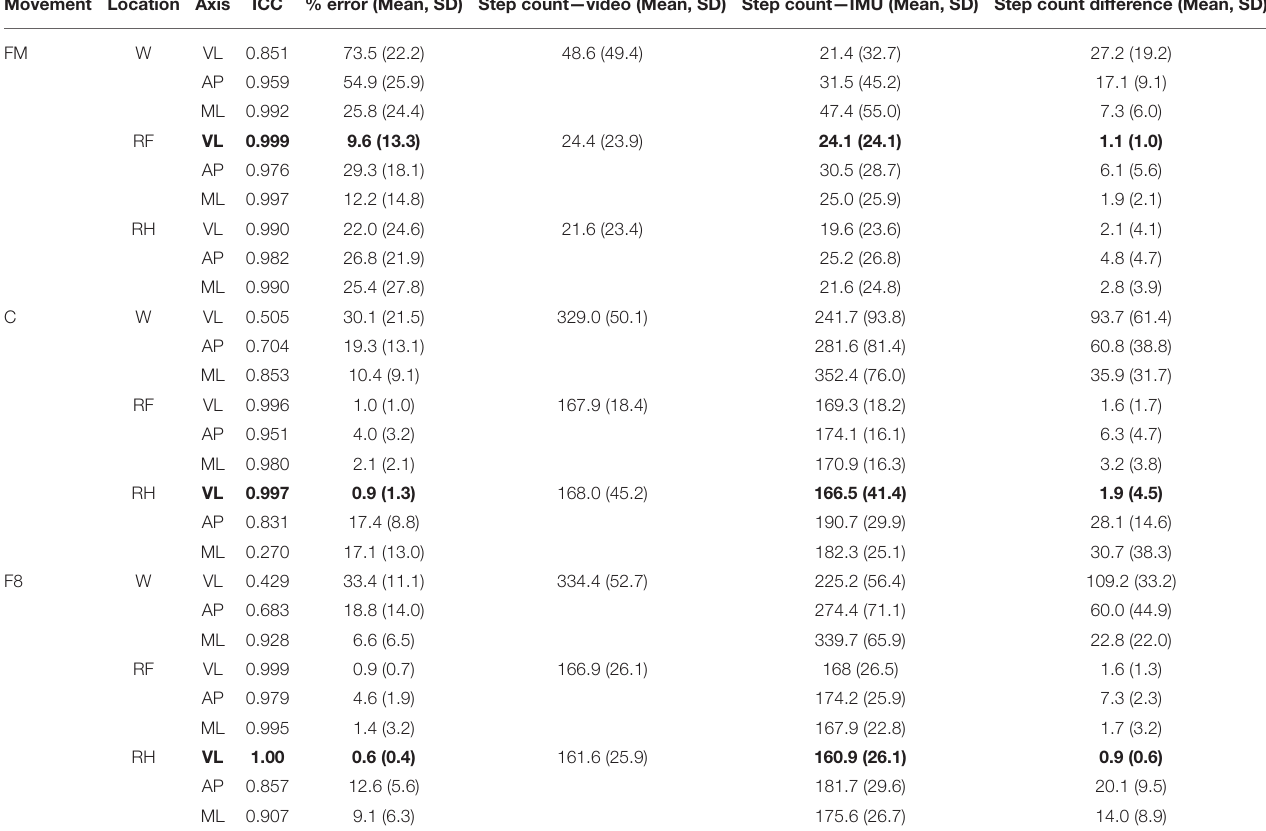
TABLE 3 | Results for the three accelerometer axes according to movement condition and sensor